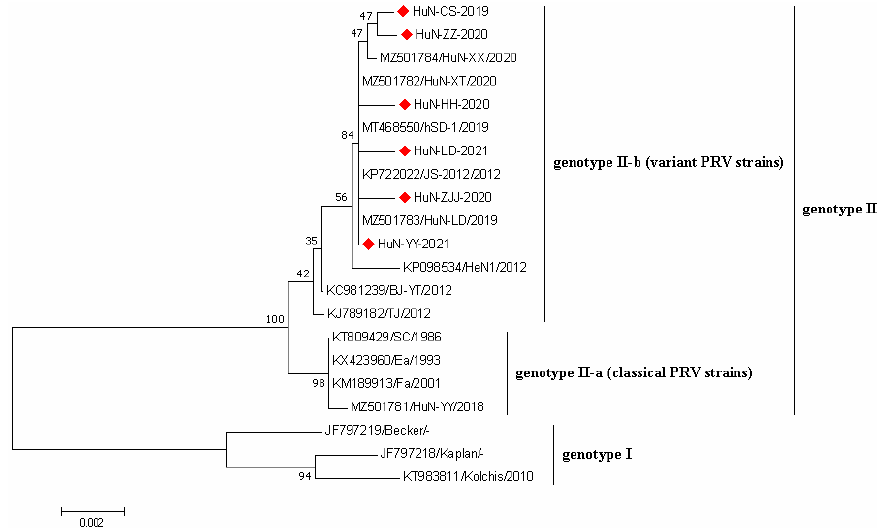
Figure 4. Phylogenetic tree based on gE gene sequences of 6 PRV strains identified in this study and other reference strains generated by the neighbor-joining method in MEGA 7.0 software, with 1000 bootstrap support. The red prismatics represented these newly identified PRV strains.